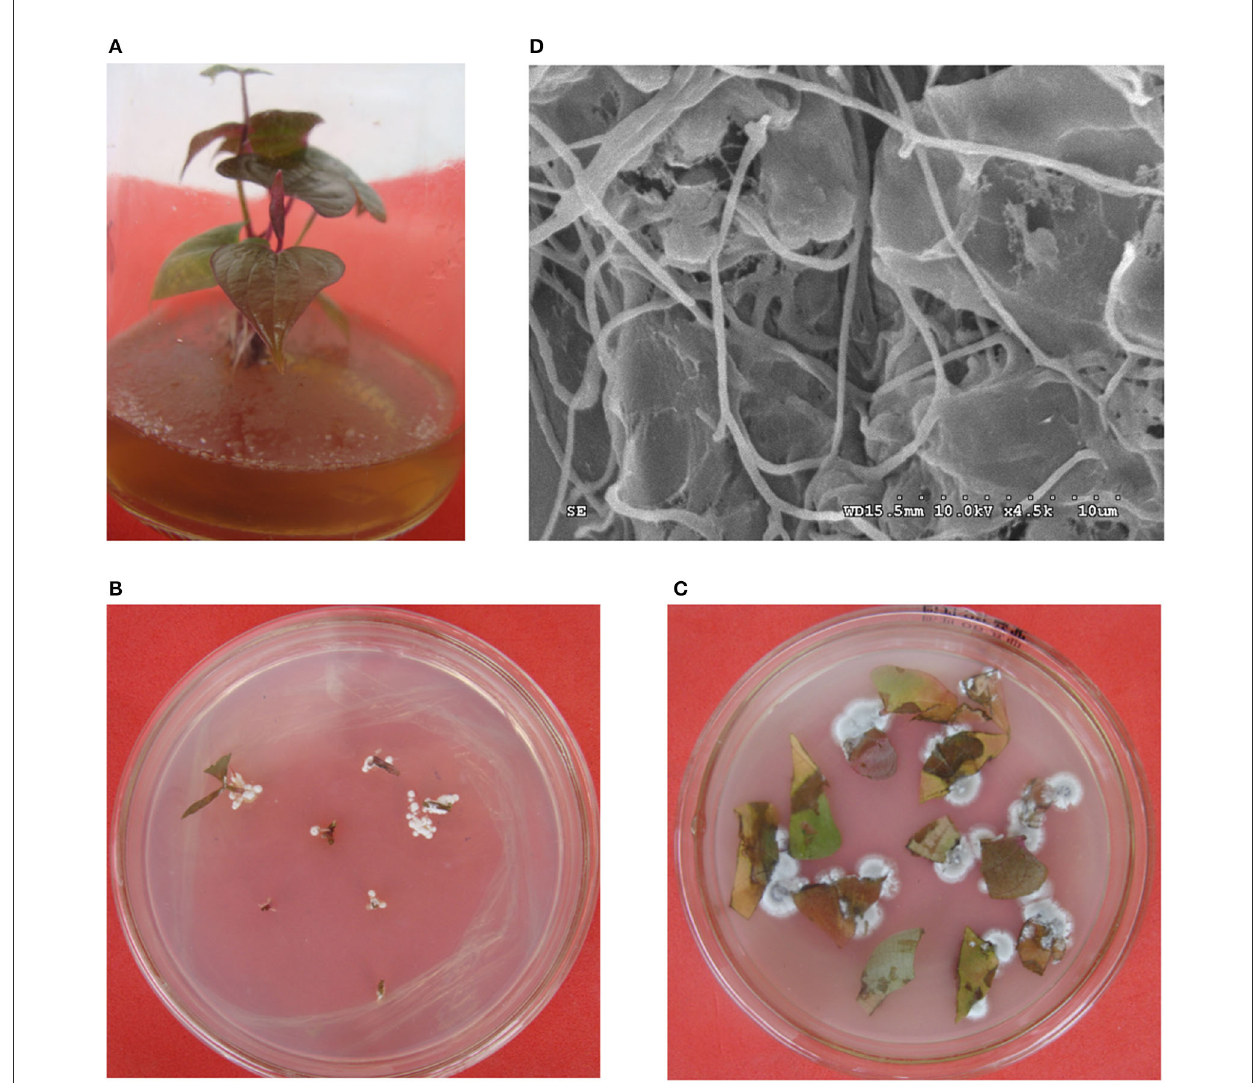
FIGURE2 Colonization of strain HNM0140 T on tissue-cultured seedlings of yam. (A) Strain HNM0140 T -colonized seedling. (B) Re-isolation of strain HNM0140 T from segments of stems of tissue-cultured seedlings of yam. (C) Re-isolation of strain HNM0140 T from segments of leaves of tissue-cultured seedlings of yam. (D) Scanning electron micrograph of the surface of leaves of tissue-cultured seedlings of yam after colonization of strain HNM0140 T